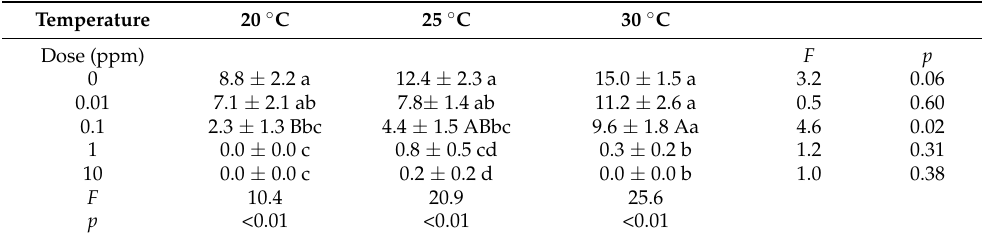
Table 5. Progeny production (adults per vial ± SE) of Prostephanus truncatus on maize treated with the WG formulation of chlorantraniliprole at five doses (0, 0.01, 0.1, 1 and 10 ppm) under three temperatures (20, 25 and 30 ◦ C) 45 days after the removal of parental adults. Within each column, means followed by the same lowercase letter are not significantly different (in all cases DF = 4, 44, Tukey–Kramer HSD test at 0.05). Within each row, means followed by the same uppercase letter are not significantly different (in all cases DF = 2, 26, Tukey–Kramer HSD test at 0.05). Where no letters exist, no significant differences were recorded.